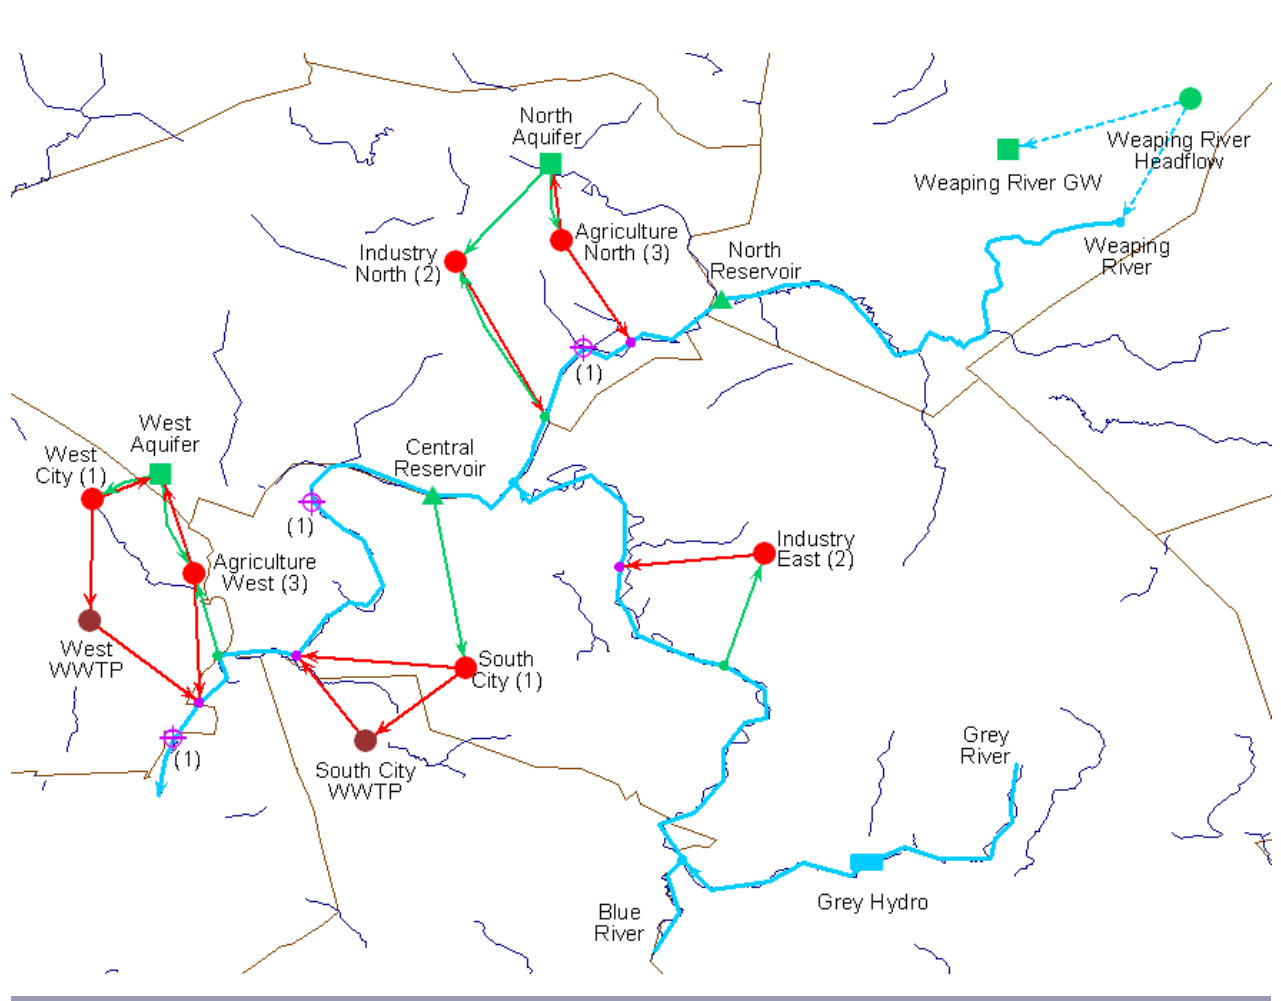
Fig. 5 . Modified Weaping River